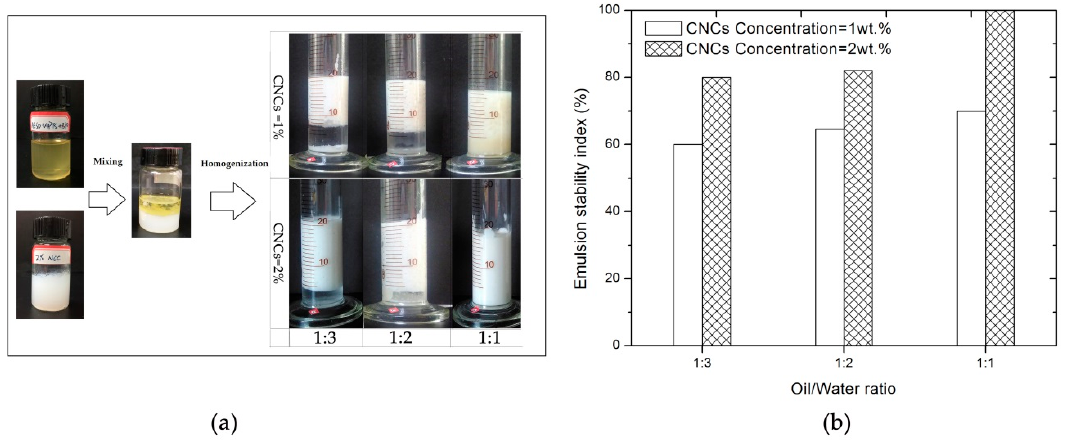
Figure 3. ( a ) Visual appearance of AESO Pickering emulsion prepared at different oil to water ratio; ( b ) effect of oil to water ratio on the emulsion stability index of the Pickering emulsions.